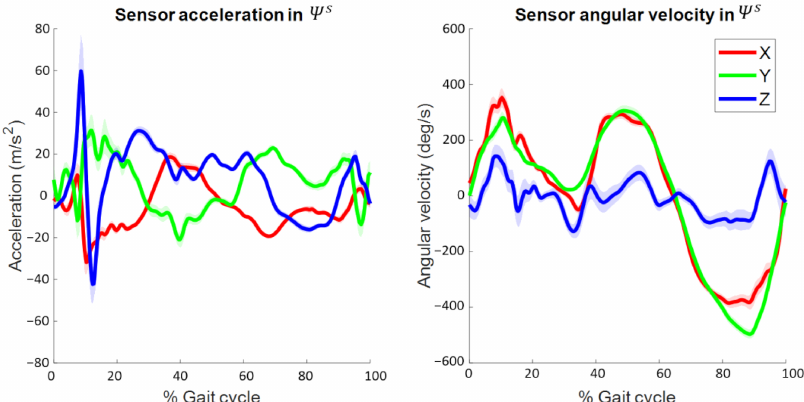
Figure 2. Three-dimensional sensor acceleration (i.e., including gravity) (left figure) and sensor angular velocity ( right ) in Ψ s as a function of the time-normalized gait cycle for a representative subject. Solid lines represent the mean while shaded areas represent the standard deviationaround the mean over one minute of running. Note that these two signals are the input for the orientation and displacement estimation algorithm. Positive acceleration values represent an acceleration into the upward, sideward ( left ), and forward direction of Ψ s . Positive angular velocity values represent anti-clockwise rotations in Ψ s